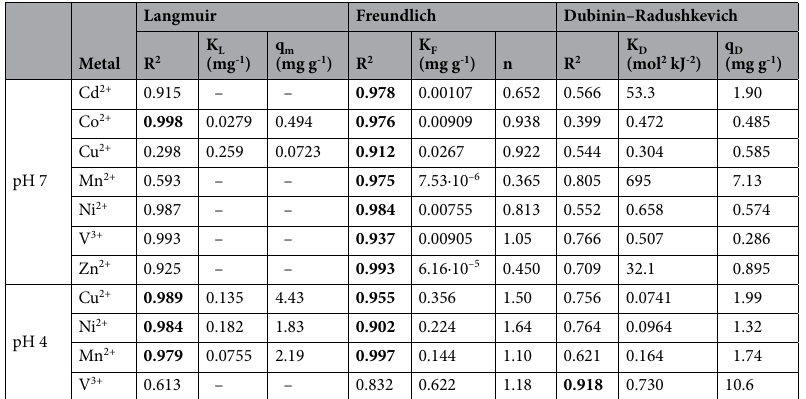
Table 3. Calculated parameters from the fitting of the adsorption isotherms with different models. The R 2 values from the isotherm model(s) that indicated the best fitting are highlighted in bold. (–) the values of K L and q m were not reported since negative and with no chemical-physical meaning.